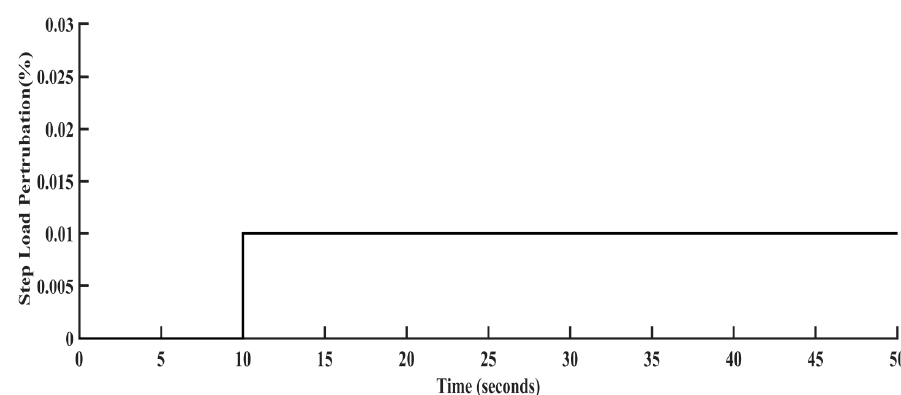
Figure 10. 1% increase in load disturbance.